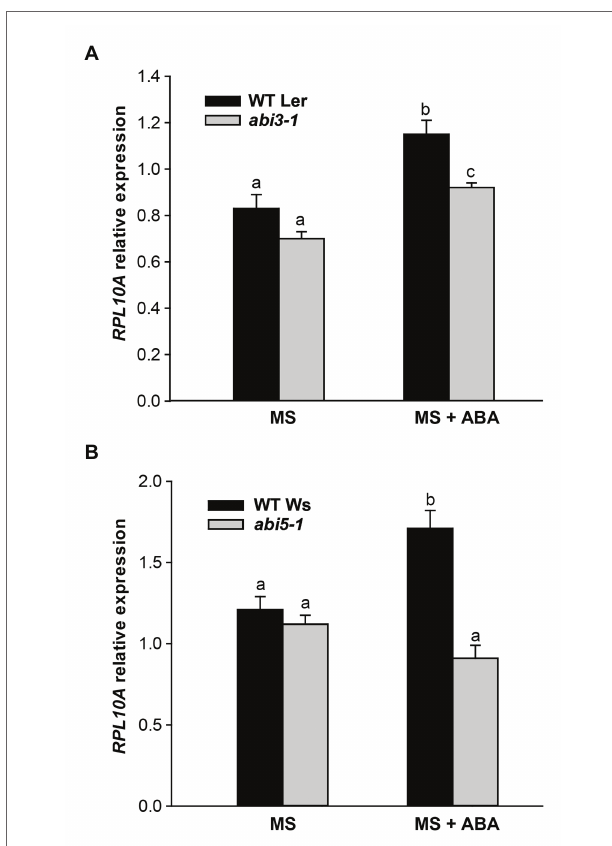
FIGURE 7 | RPL10A expression analysis in abi3 and abi5 mutant plants. RPL10A transcript levels in abi3-1 (A) and abi5-1 (B) mutant plants and their respective WT background plants (Ler and Ws, respectively) grown in MS-agar medium without (MS) or with 1 μ M ABA supplementation (MS + ABA). ACTIN2 transcript accumulation was used as a reference. Results represent the average ± SE of three biological replicates. Different letters over the bar indicate statistical differences between samples applying ANOVA test ( p <